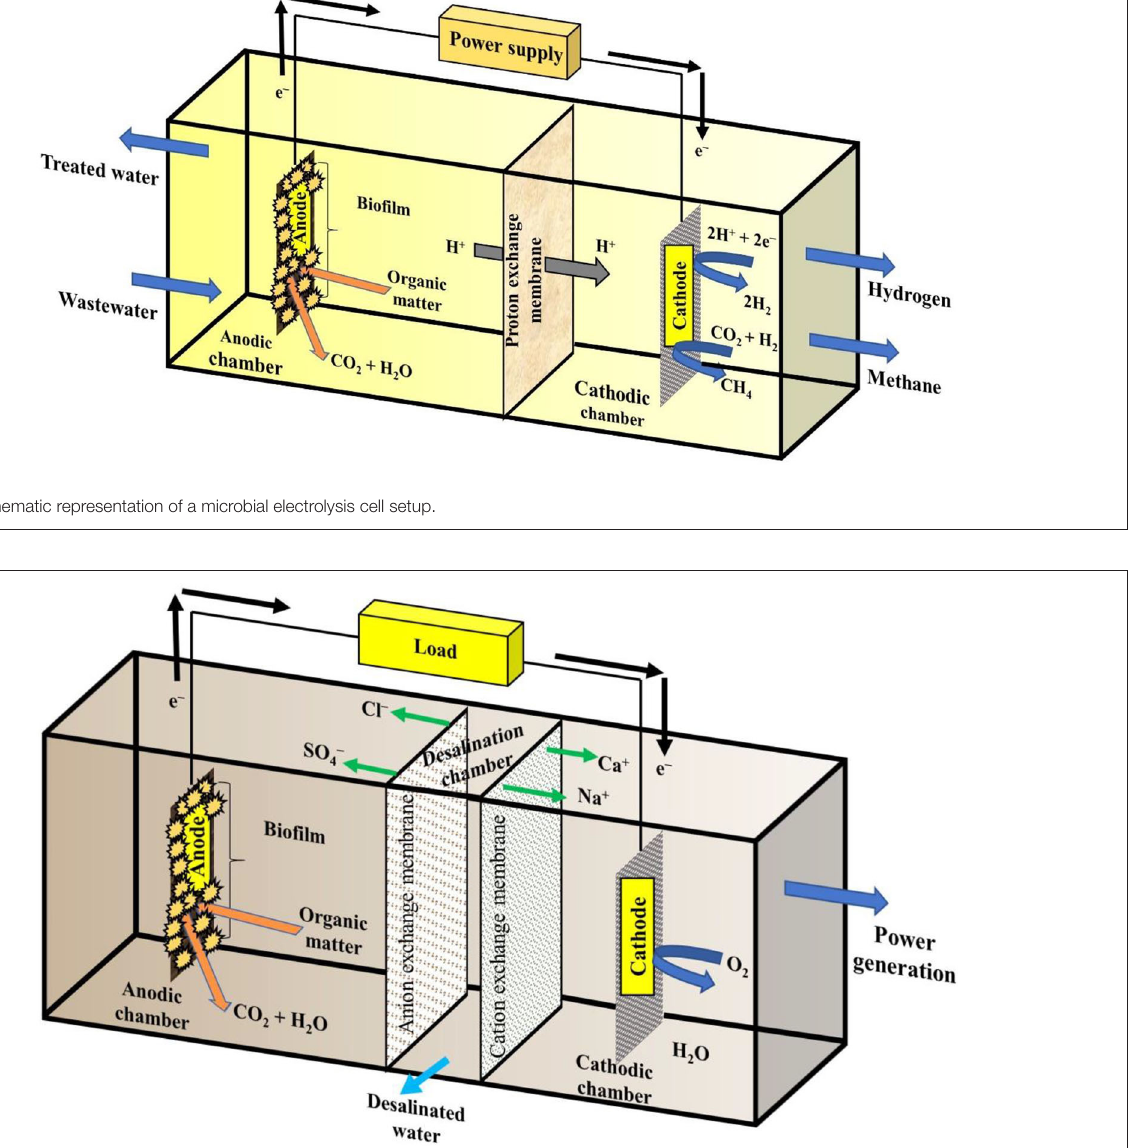
FIGURE 3 | Schematic representation of microbial desalination